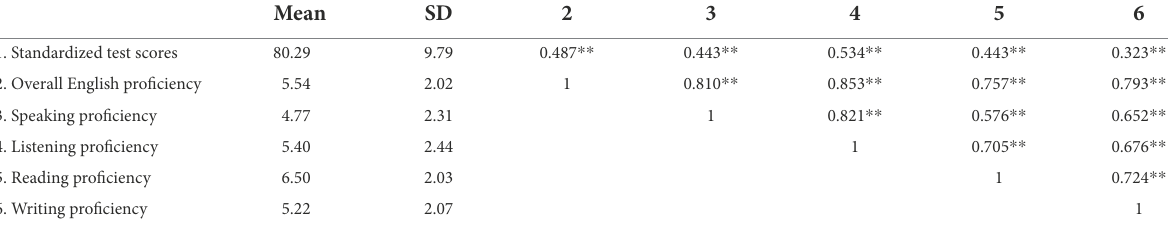
TABLE 1 Means, standard deviations and correlations of English achievements measured in different